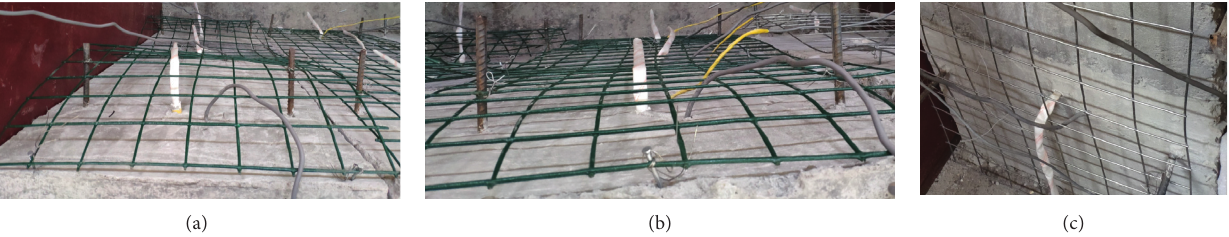
Figure 6: The reinforced net laying. (a) Flexible net wavy laying reinforcement. (b) Flexible net flat laying reinforcement. (c) Barbed wire flat laying reinforcement.